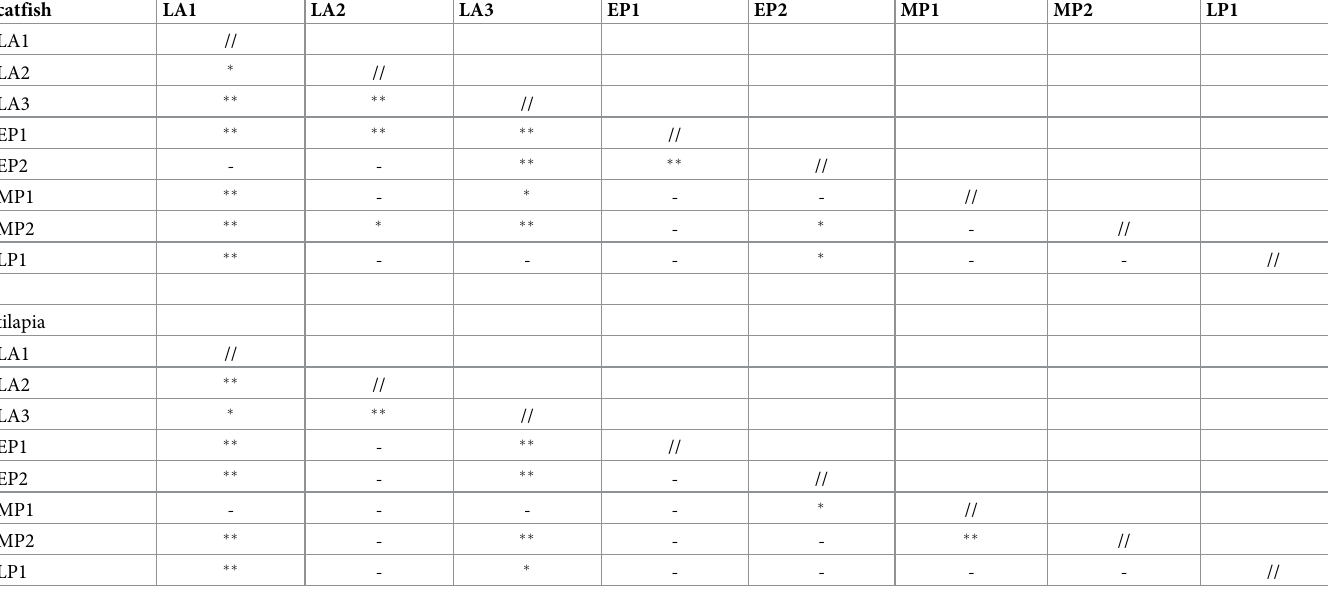
Comparison of the means of the catfish and the tilapia between periods using T-test (PAST, version 3.26b): no difference: -; significant different: p < 0.05 � , highly significant different p < 0.01